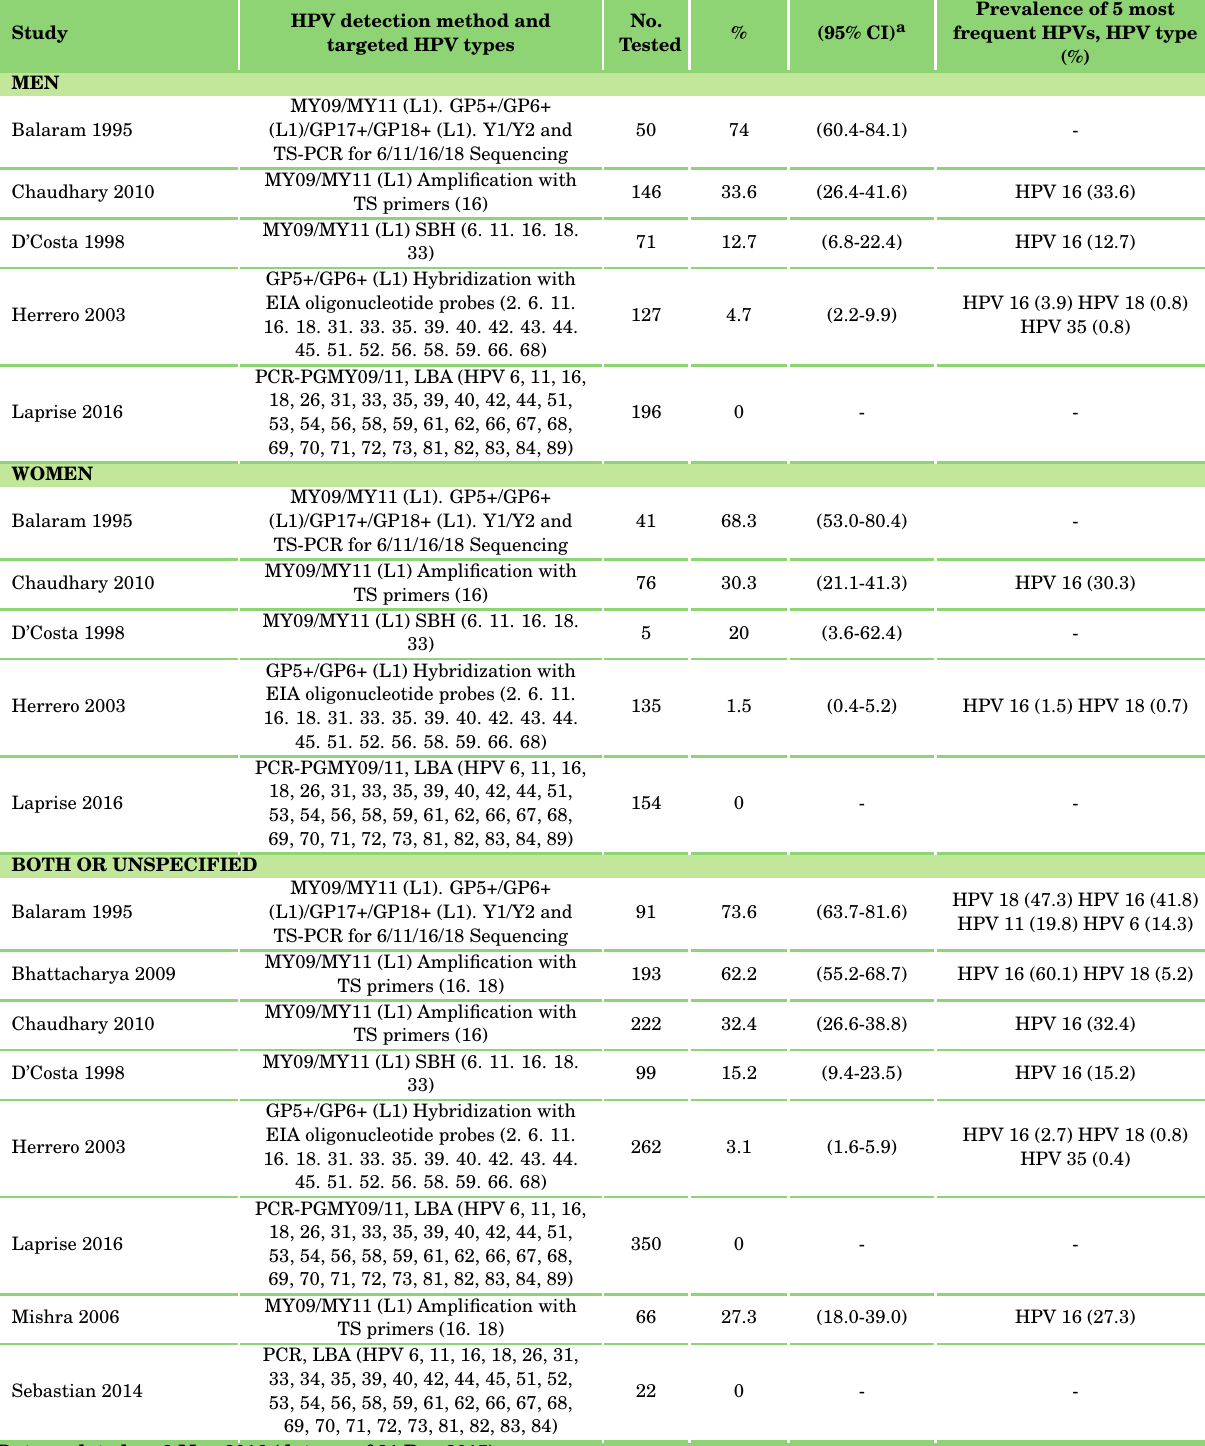
Table 36: Studies on HPV prevalence among cases of oral cavity cancer in